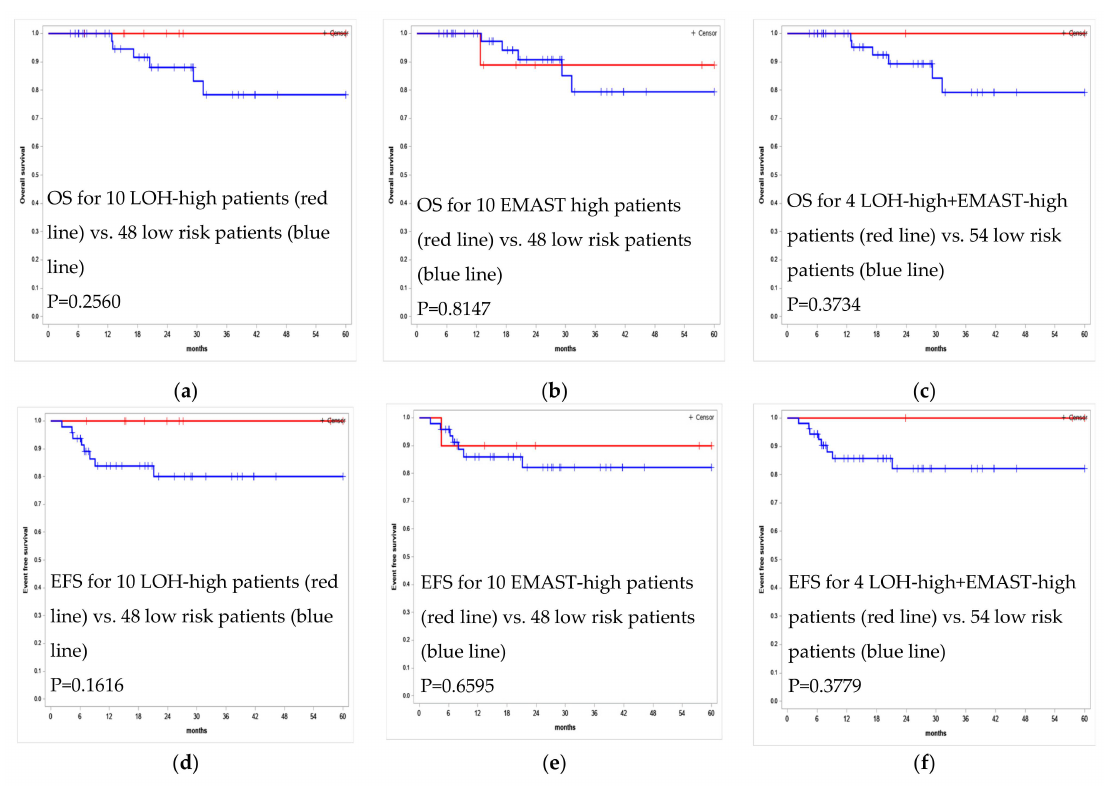
Figure 6. Kaplan–Meier survival curves for OS and EFS estimates according to the LOH-high and EMAST-high status in tumor STR profile for 58 PMBCL patients undergoing R-Da-EPOCH-21 therapy. ( a ) OS for 10 LOH-high patients vs. 48 low risk patients ( b ) OS for 10 EMAST high patients vs. 48 low risk patients (c) OS for 4 LOH-high + EMAST-high patients vs. 54 low risk patients ( d ) EFS for 10 LOH-high patients vs. 48 low risk patients ( e ) EFS for 10 EMAST-high patients vs. 48 low risk patients ( f ) EFS for 4 LOH-high + EMAST-high patients vs. 54 low risk